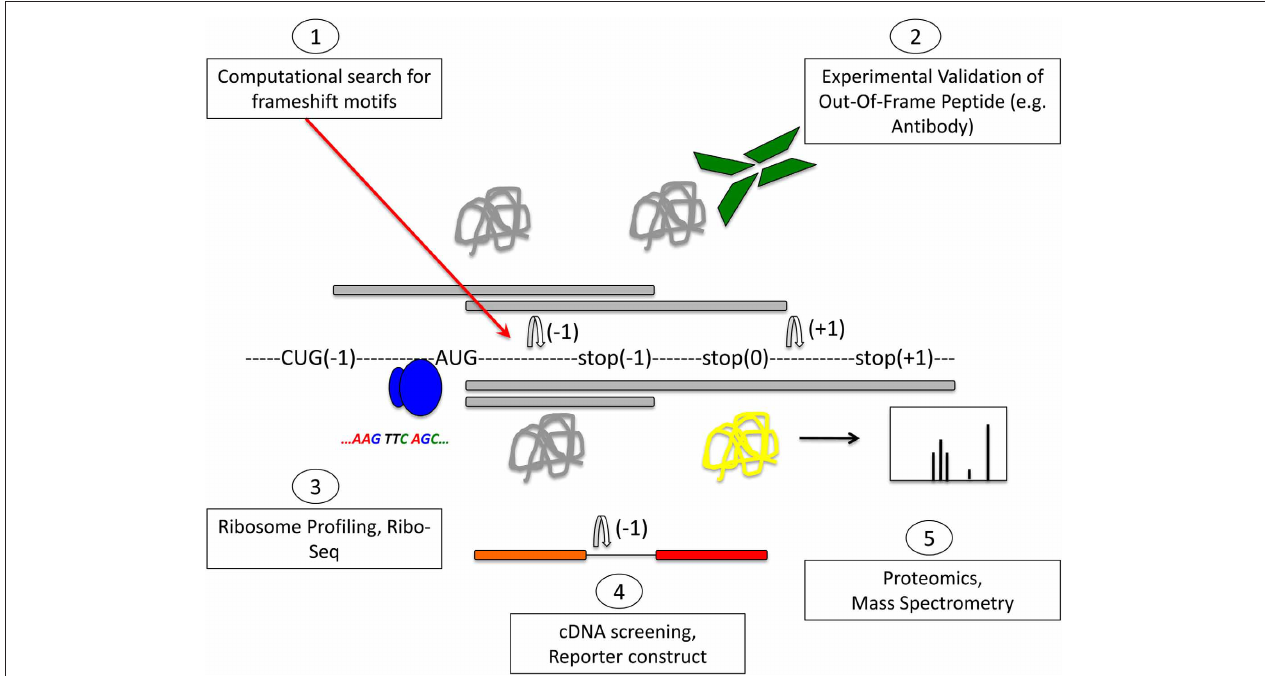
FIGURE 3 | Methods to detect frameshifting events and out-of-frame peptides. Computational methods (1) using databases that interrogate the genome for − 1 or + 1 frameshift motifs can give information about frameshifting events. Limitations of this approach are that only known frameshift motifs are taken into account. Furthermore, this method does not give any information whether predicted frameshift events occur in vivo or the functional relevance of frameshifting events. Experimental methods (2) can identify frameshift events that occur in vivo . Most commonly, an antibody that is specific to the out-of-frame sequence of the frameshifted protein is used to detect frameshifted proteins. Ribosome profiling methods such as